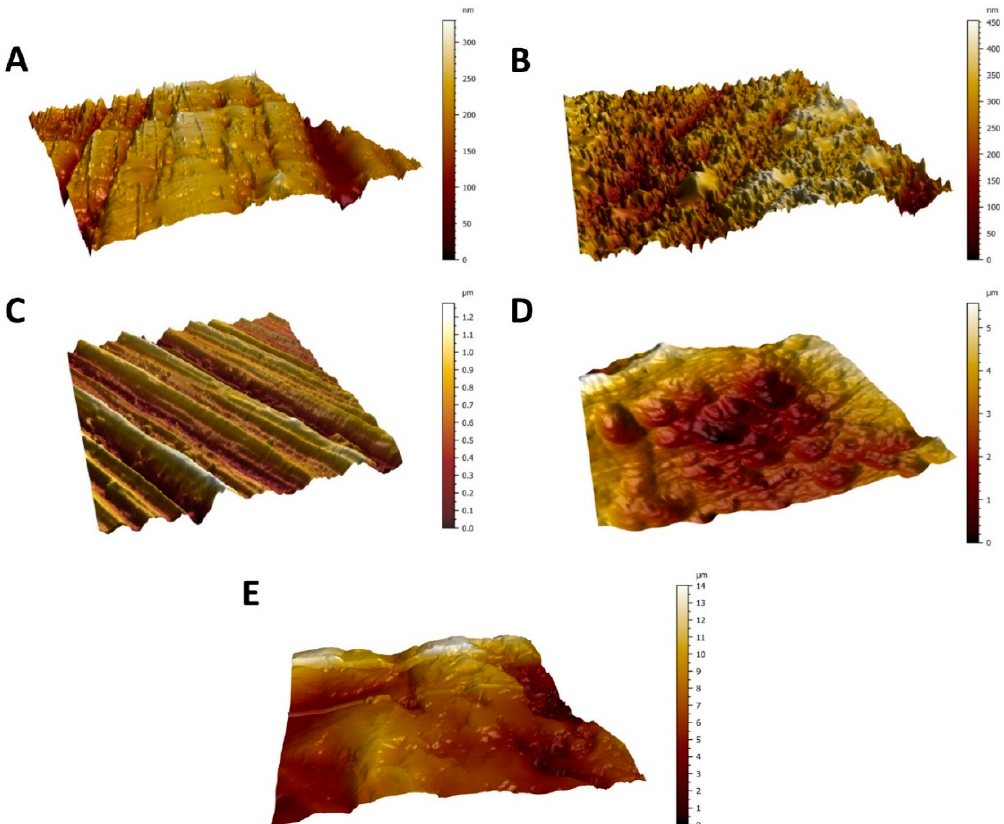
Figure 1. AFM micrographs showing the surface topography of the Ti6Al4V surfaces from the smoothest to the roughest—polished surface ( A ), diamond-like carbon (DLC)-coated surface ( B ), brushed surface ( C ), anodized surface ( D ), and blasted surface ( E ). Scanned area = 50 × 50 μ m 2 .